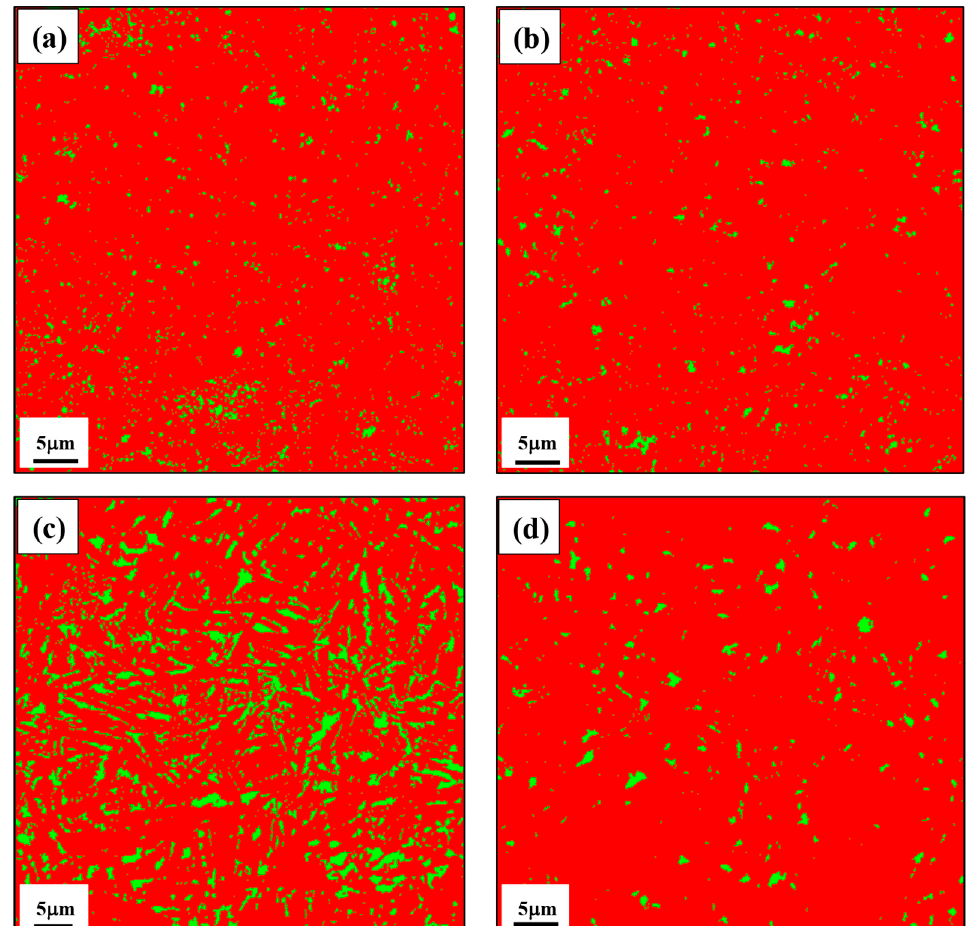
Figure 5. EBSD images of PMs for the samples held isothermally at 350 ◦ C salt bath for: ( a ) 5 s; ( b ) 30 s; ( c ) 200 s; ( d ) 1 h; and then followed by subsequent quenching in water. The green regions are FCC retained austenite and the red ones are BCC bainite and / or martensite. The bainite and martensite regions cannot be detected from each other in these electron micrographs.